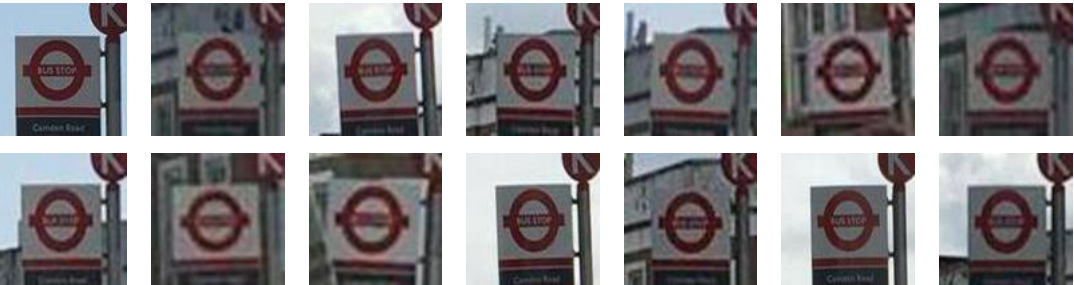
Figure 7. A single instance of a traffic sign from the Mapillary dataset acquired from different sensors, angles, and